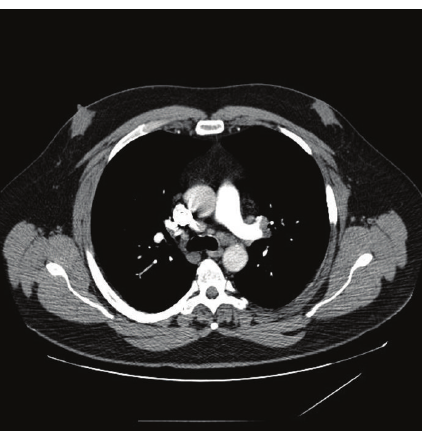
Figure 1: CT Chest showing mediastinal lymphadenopathy.